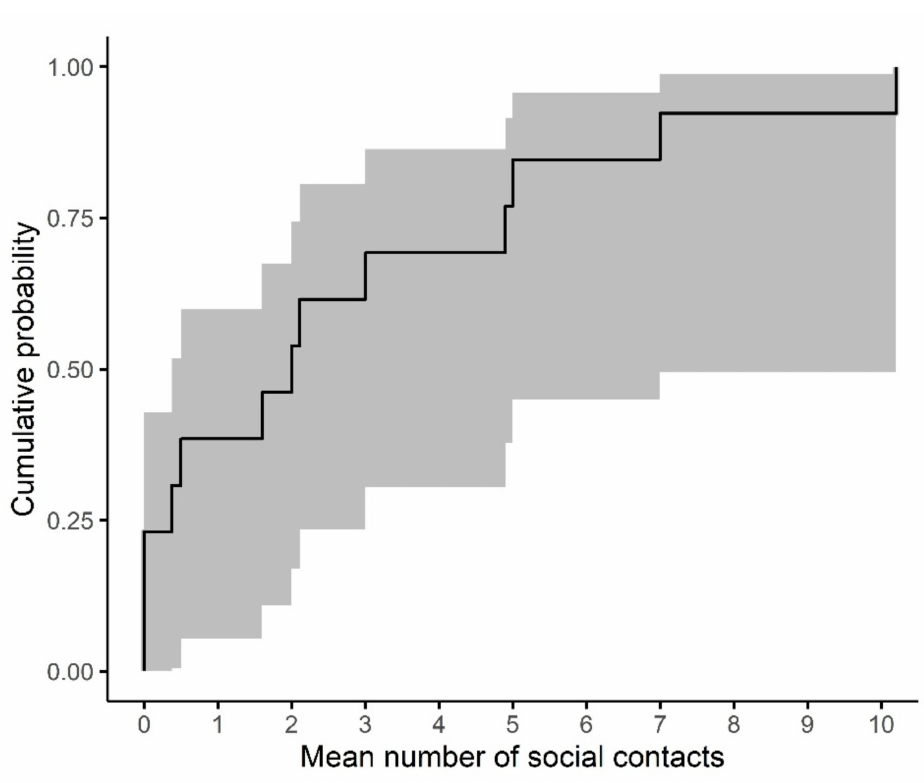
Figure 5. Cumulative distribution of the mean number of social contacts per CAMP-remote partici- pant (n = 13) per day. Shaded area represents 95% confidence